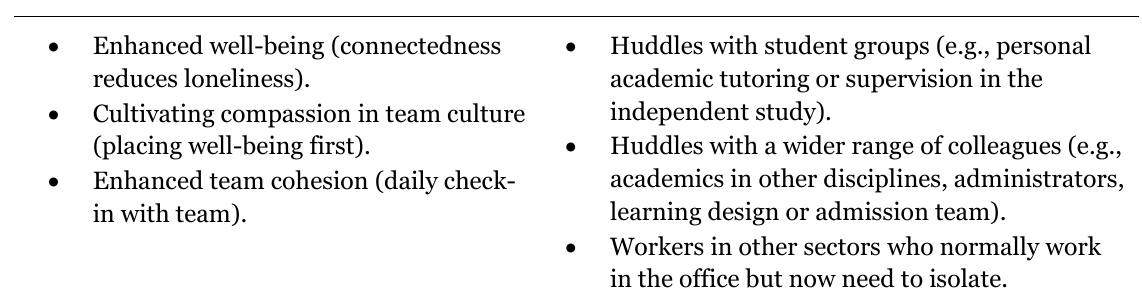
Characteristics of Online Morning Huddles Perceived positive impacts Suggestions for possible